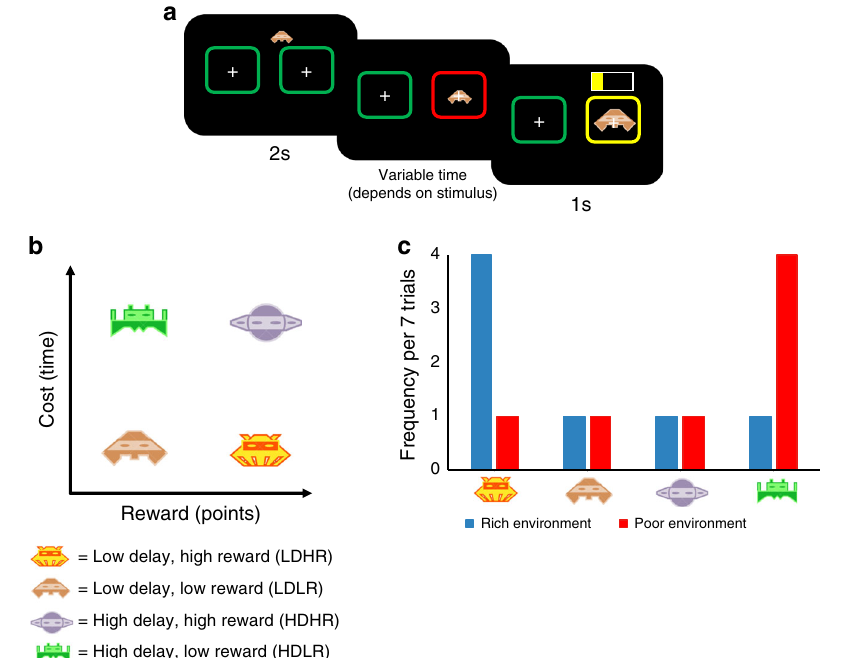
Fig. 1 Behavioral task and variables. a Timeline of the task. On each trial, an option (presented as one of four different aliens) approached one of two targets. Participants decided to accept the option by selecting the target the option approached (right target in this example) or reject the option by selecting the alternative target (i.e. the target the option did not approach, left target in this example). When options were accepted, the selected target changed color to red and participants were required to maintain a key press during which the option expanded within the target. The target then changed color to yellow indicating that participants could release the key press and the number of points obtained was displayed represented as a partially fi lled horizontal bar. When options were rejected, the experiment immediately progressed to the next trial. b On each trial, participants encountered one of four possible options each of which provided either a low/high reward (points, later converted to a bonus payment) but also incurred either a short/long opportunity cost in the form of a time delay. c The experiment was divided into two blocks (environments) and the frequency of the four different options varied in each of these. There was a rich environment in which the best option (low delay, high reward) outnumbered the other three options and a poor environment in which the worst option (high delay, low reward) outnumbered the other three options. The order of the blocks was counterbalanced between participants. Stimuli were designed by Sahua (https://www.123rf.com/pro fi le_sahua) and are copyrighted property of 123RF